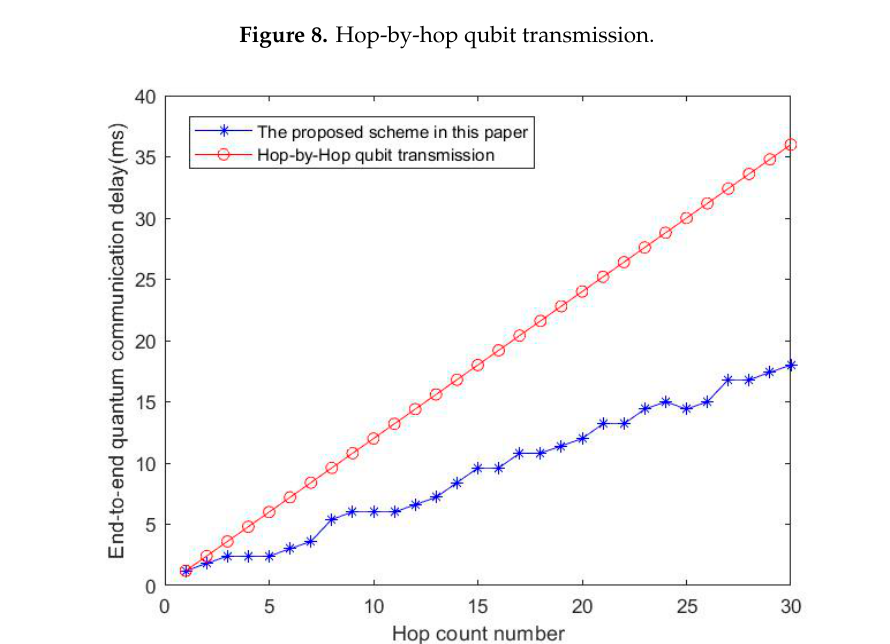
Figure 9. The comparison of two schemes in terms of communication delay.